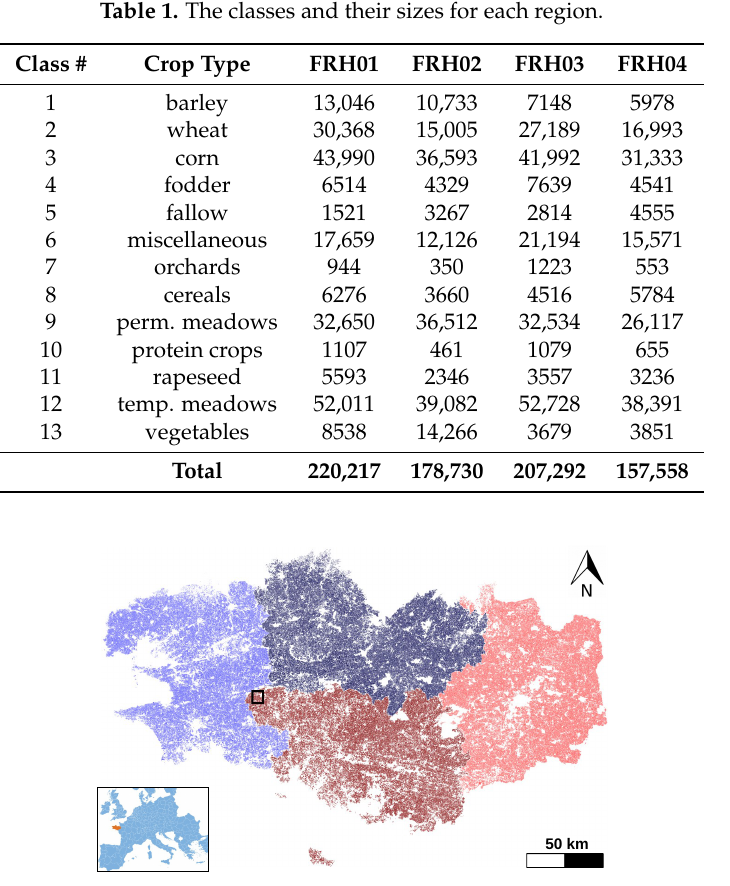
Figure 4. The regions of Brittany from which the dataset stems: FRH01, FRH02, FRH03 and